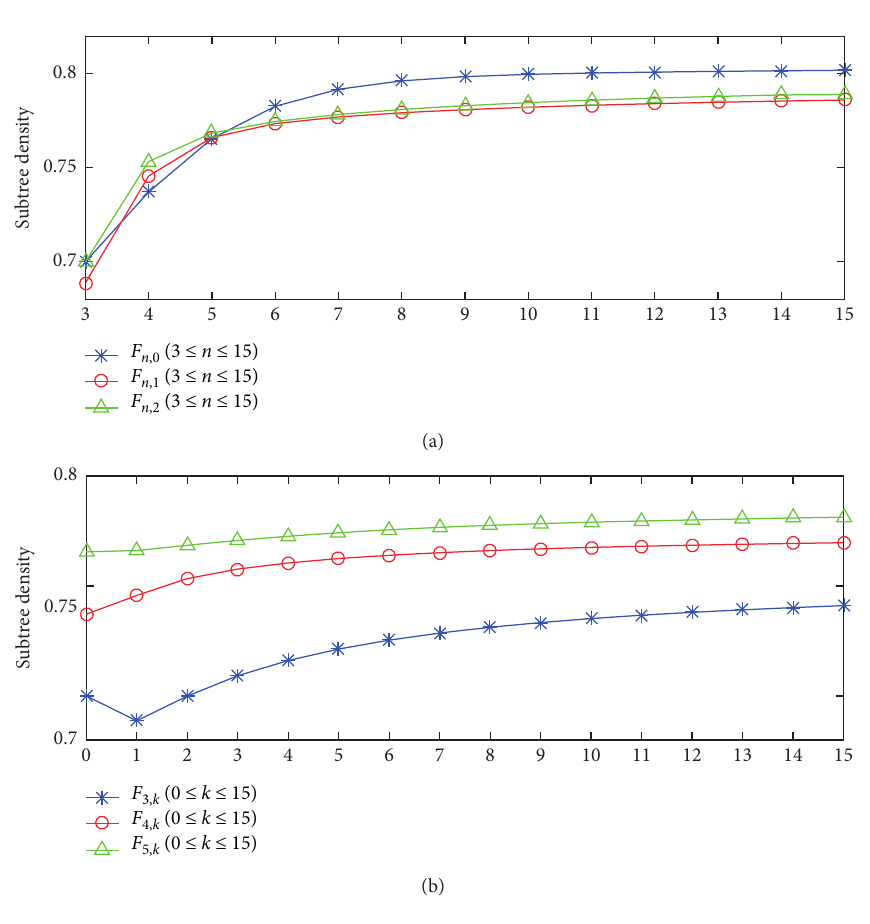
( n � 3 , 4 , ... , 15 ; k � 0 , 1 , ... , 15 ) . (a) Subtree densities of F n,k